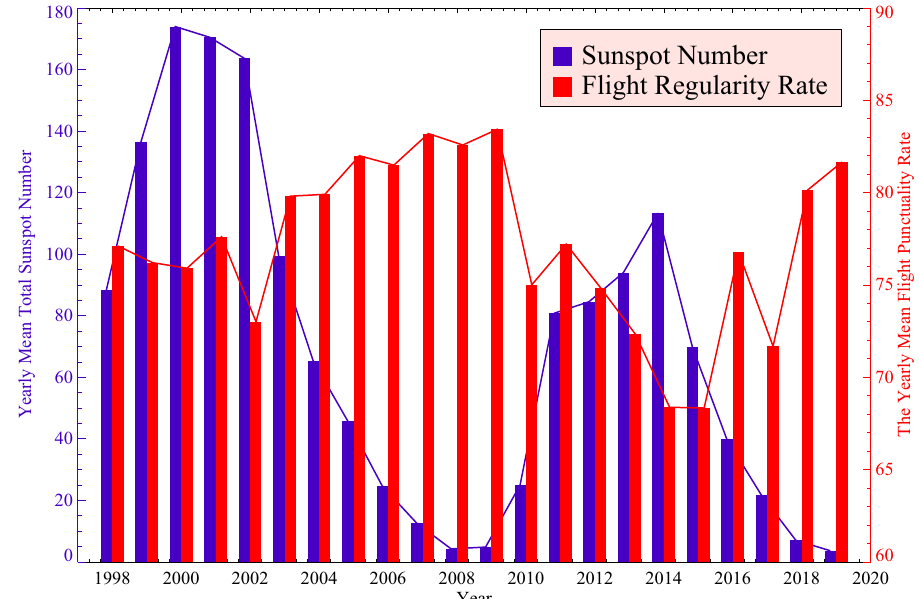
Figure 4. The yearly flight regularity rate of China (red) versus the yearly mean total sunspot number (blue) from 1998 to